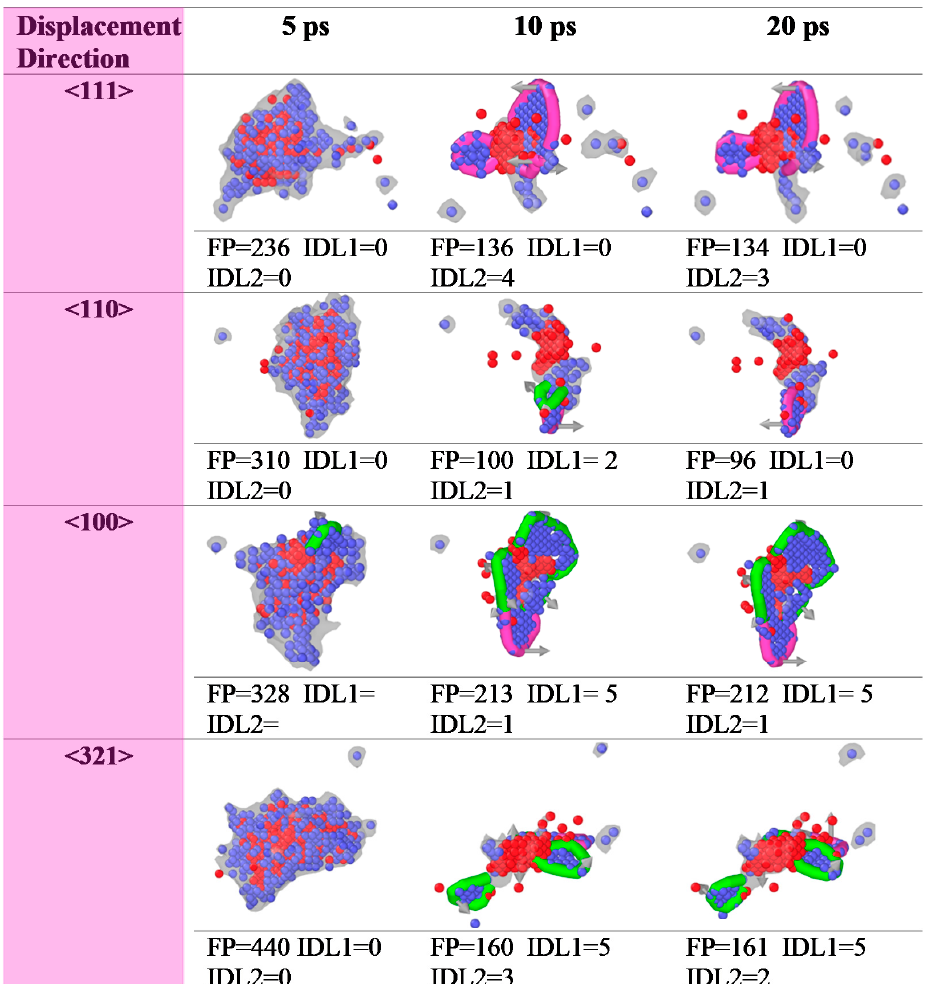
Figure 5. Snapshots of the FPs evolution and IDLs creation at various displacement directions. The simulation event approached by using the 14 keV of PKA and 1.6% of strain within 20 ps of time. Red atoms represent the site of vacancies; blue atoms represent the SIA; green loops represent 1 ½<111> dislocation, i.e., IDL1; and pink loops represent the <100> dislocation, i.e., IDL2. The defect mesh is represented by the grey foam surrounding the atoms (like any other surface mesh). The grey arrows represent the dislocations’ Burger vectors.